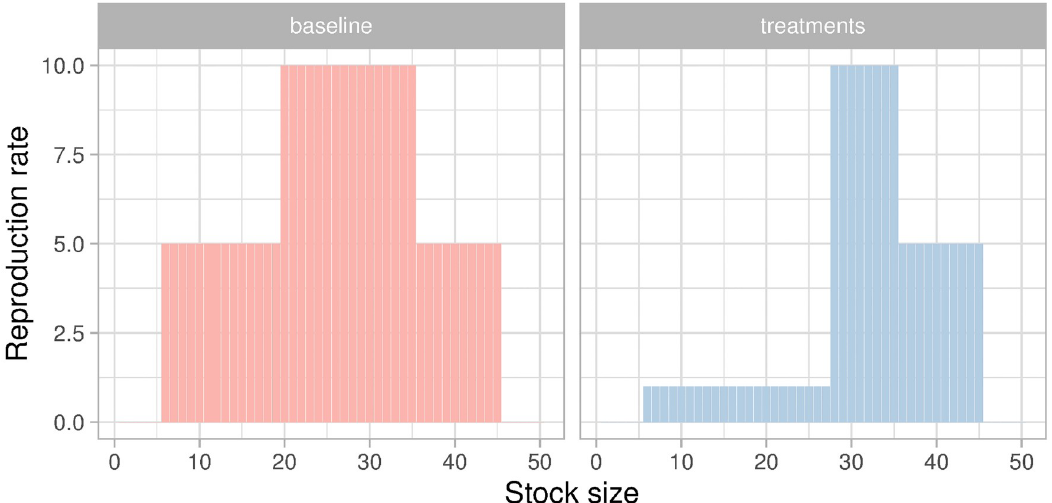
Fig 1. Reproduction rate as function of stock size. Treatments where the climate event triggers the threshold effect (threshold, risk, and uncertainty) can have a lower reproduction rate if the stock size is below 28 fish.